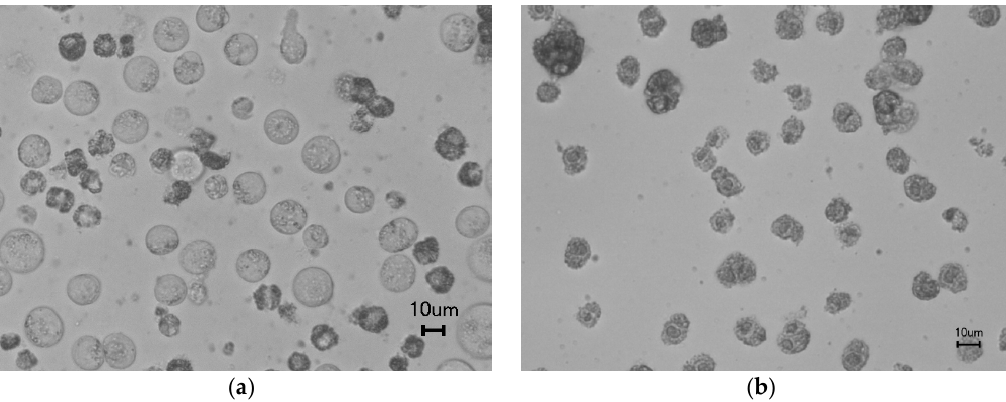
Figure 2. The images of untreated ( a ) and treated ( b ) CCRF cells with essential oil of Foeniculum vulgare.